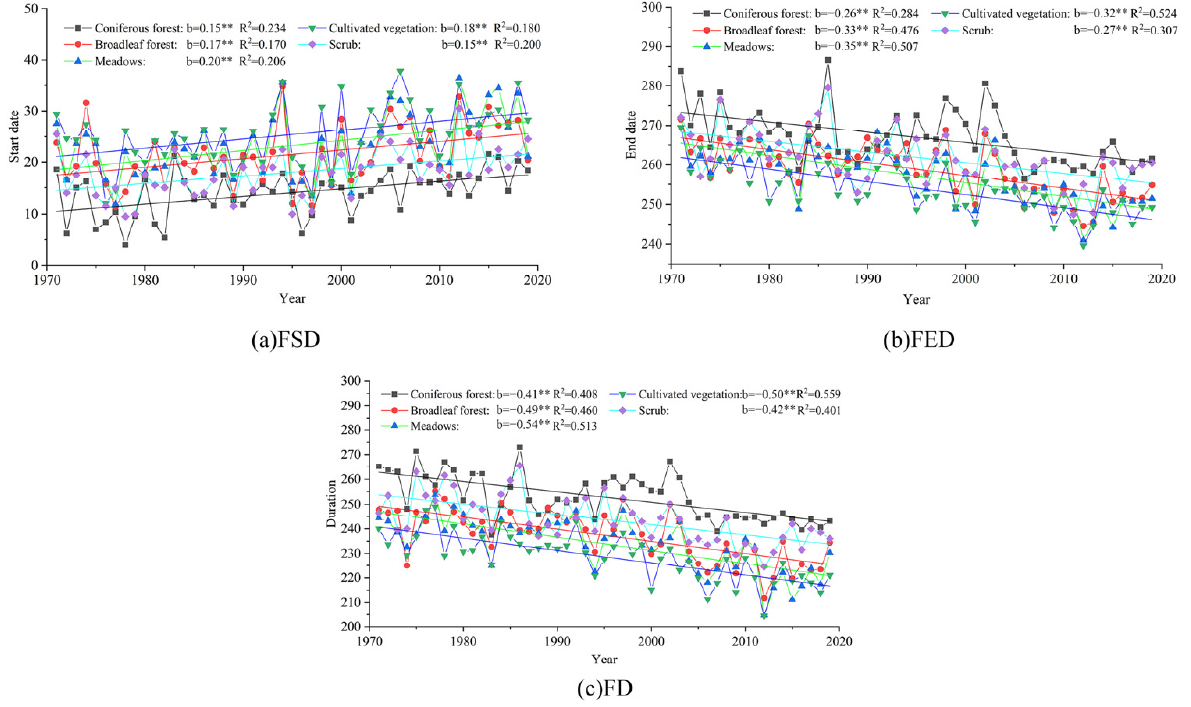
Figure 7. Trends in key variables of the soil freeze–thaw processes under different vegetation cover types (** indicates reaching a significance level of α = 0.01).